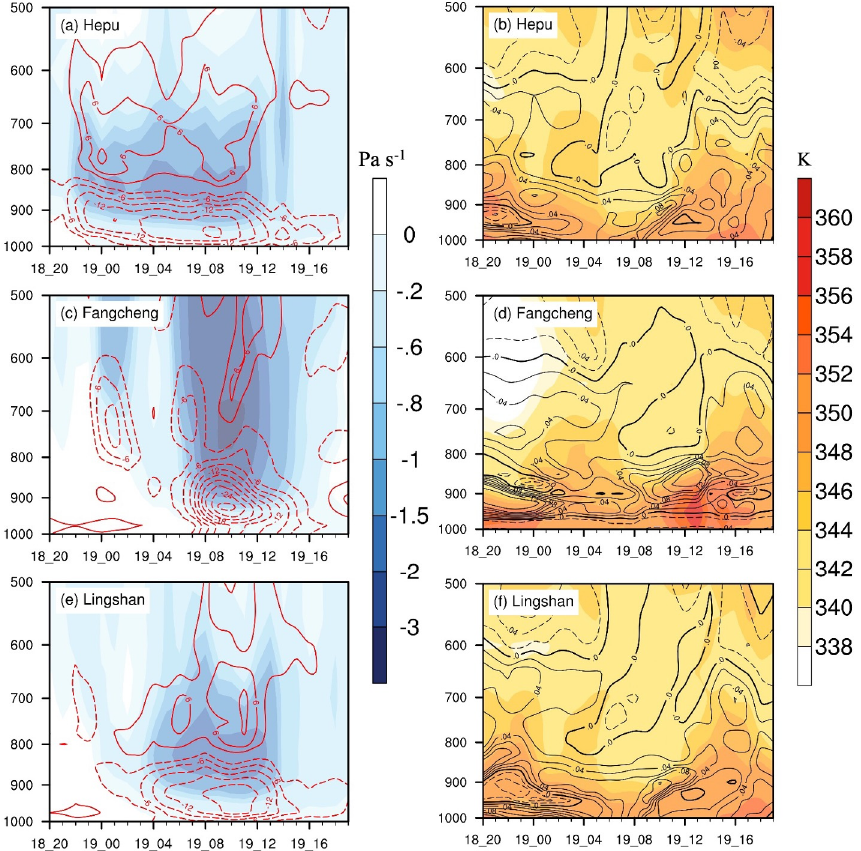
Figure 7. Left panels ( a , c , e ): the time–pressure cross sections of the area-averaged (1° × 1°) vertical velocity (shadings, Pa s − 1 ) overlaid with divergence (contours, 10 − 5 s − 1 ) from ERA5 for three rainstorms centered at Hepu, Fangcheng, and Lingshan. Right panels ( b , d , f ): the same except for equivalent potential temperature (shadings, K) overlaid with its corresponding gradient (contours, K Pa − 1 ).